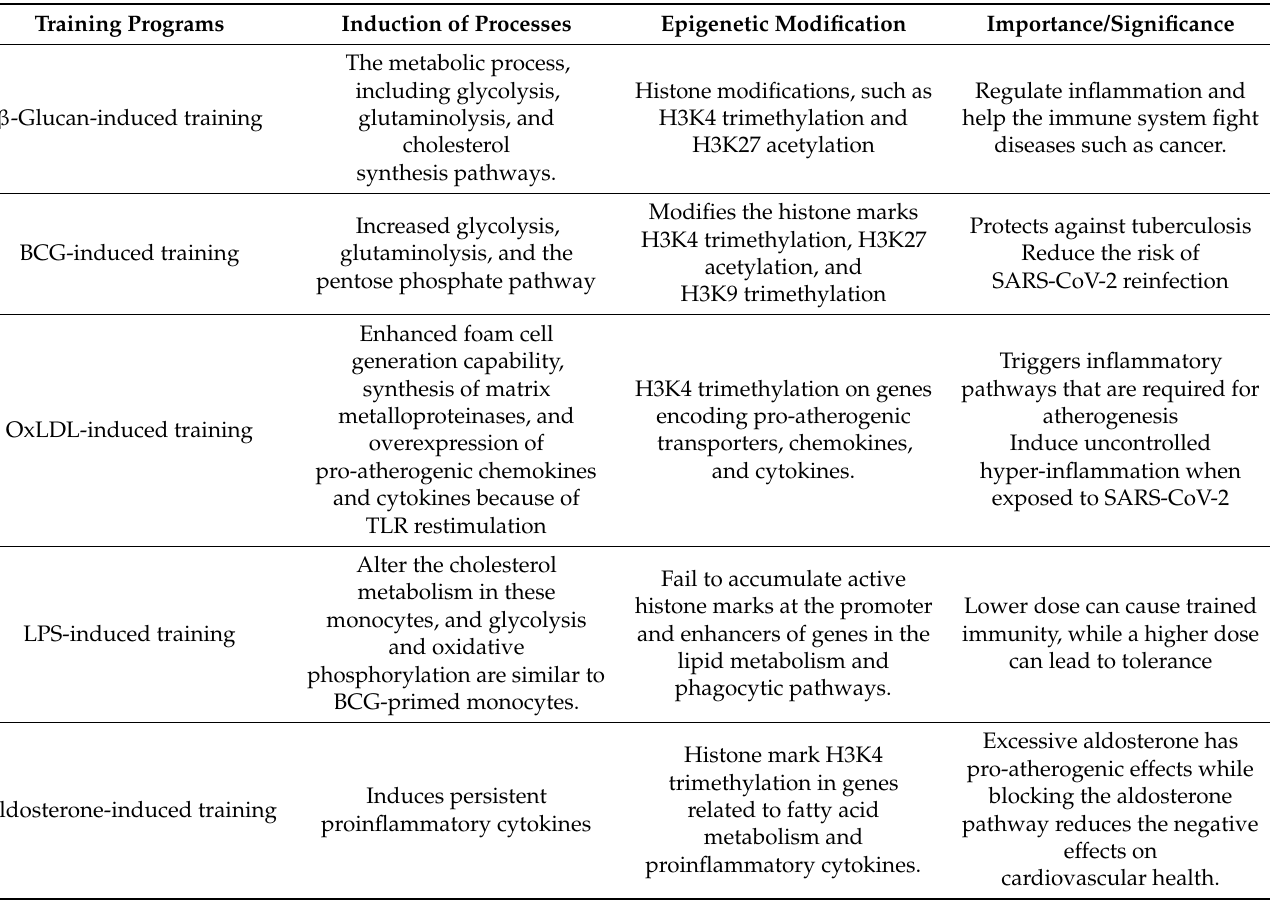
Table 1. Various components of training programs of